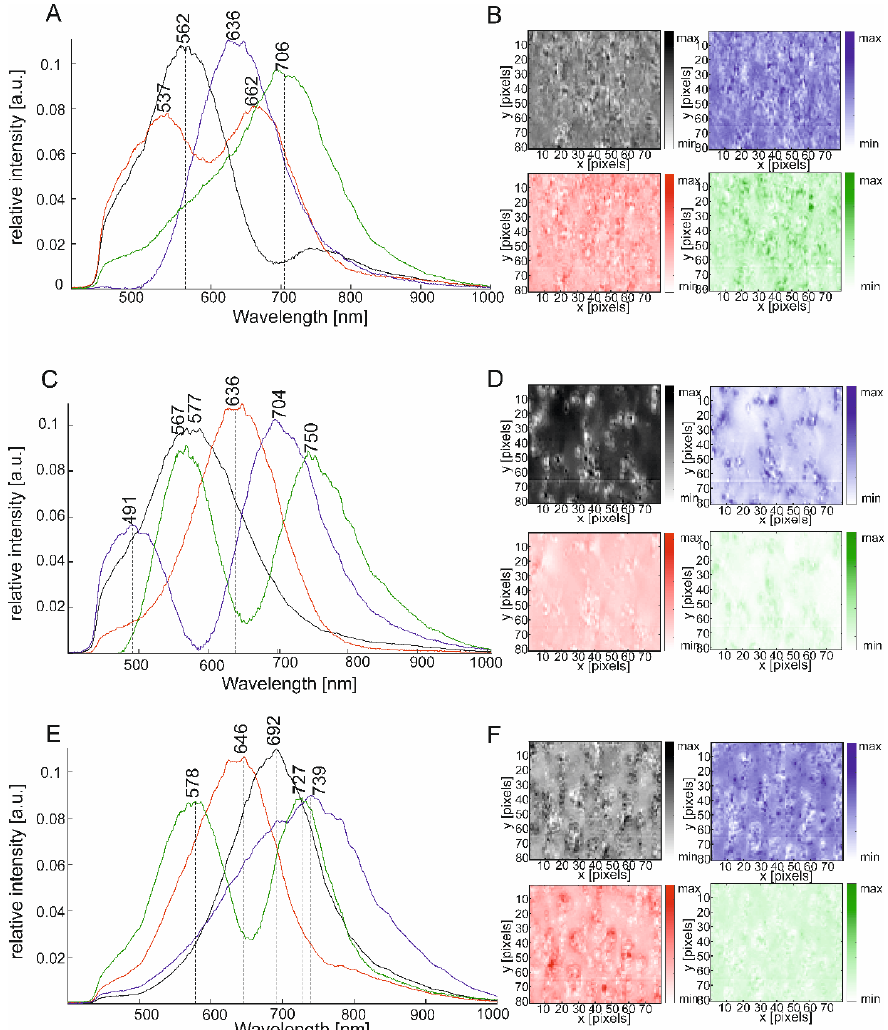
Figure 5. Results of the NMF decomposition of data sets of ( A , B ) gold nanoparticles, ( C , D ) gold nanoaggregates generated by adding sodium chloride, and ( E , F ) agglomerates of gold nanoparticles and BSA. ( A , C , E ) Four components that were used to construct four maps in ( B , D , F ) in corresponding color for each of the samples. The maps indicate the relative contributions of the respective component in each of the data points.